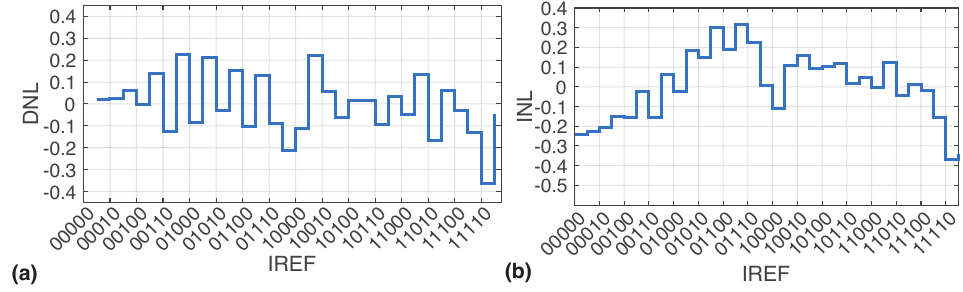
Figure 11. Stimulation current’s ( a ) DNL and ( b ) INL. Both were measured for a 4.7k Ω load and V DDH = 11V and are represented as a fraction of one